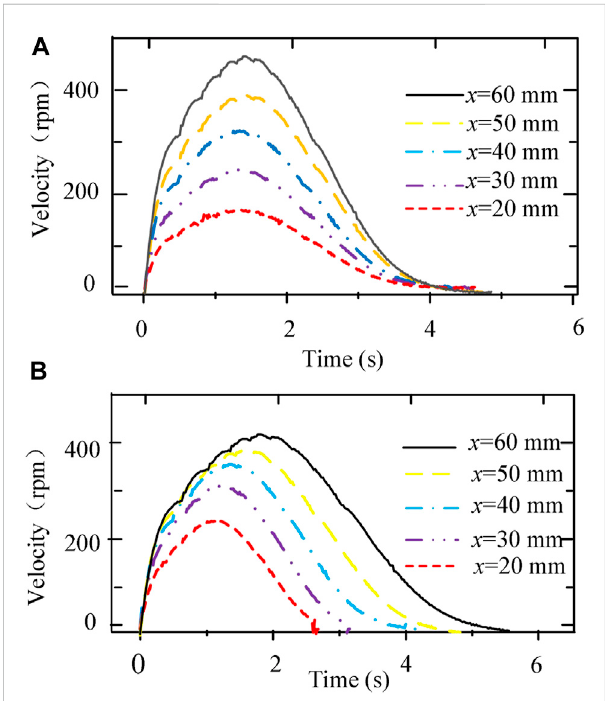
FIGURE 12 The velocity response curves of X motor to different target displacements (A) without variable domain and (B) with variable domain are tested through